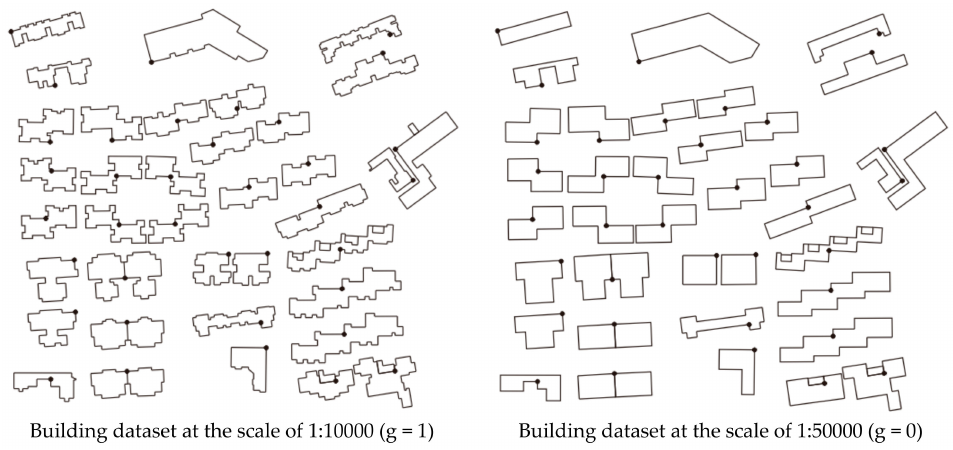
Figure 8. Beginning and end states of the experimental data.